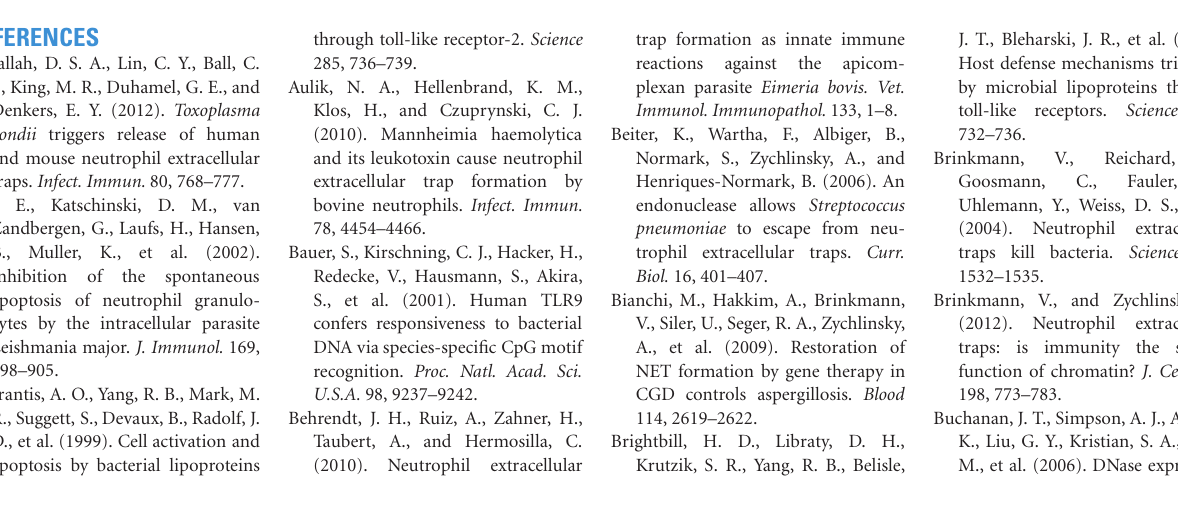
with inflammatory mediators will produce NETs more readily if treated with a second